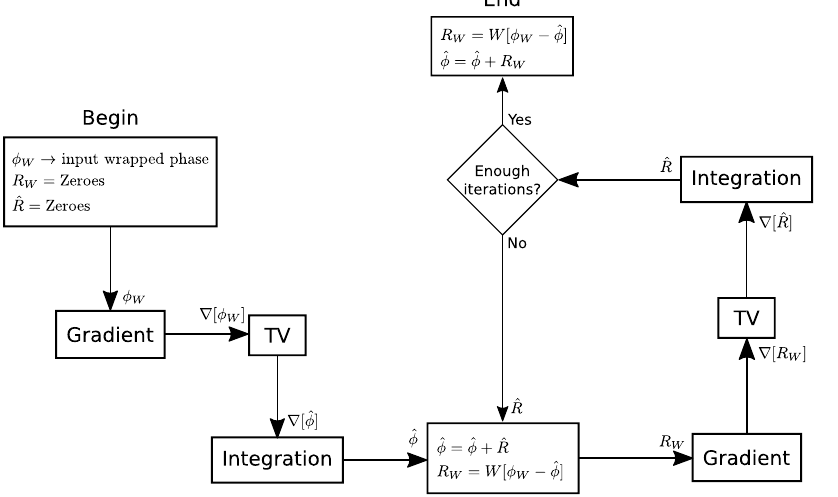
Figure 9. Block diagram of the method presented in ref. 16. As with our method, the gradient is taken by means of finite differences. As recommended in ref. 16. we use 500 iterations in the experiment reported